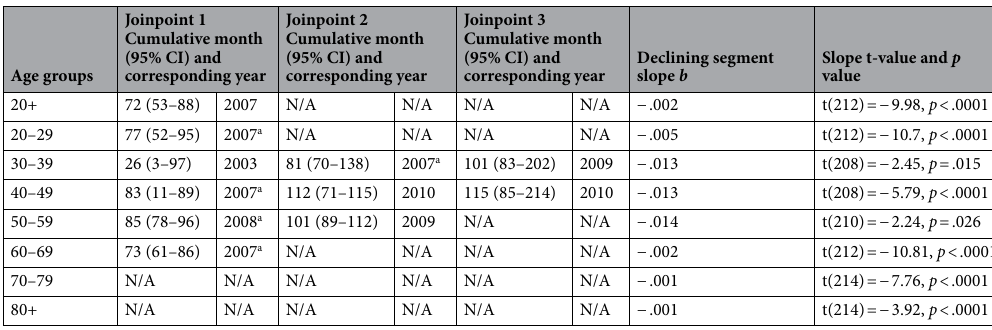
Table 1. Joinpoint location, confidence interval and trend of declining segment by age group. Joinpoint locations are number of months since the beginning of the dataset (e.g., January 2001 = month 1). a Declining slope